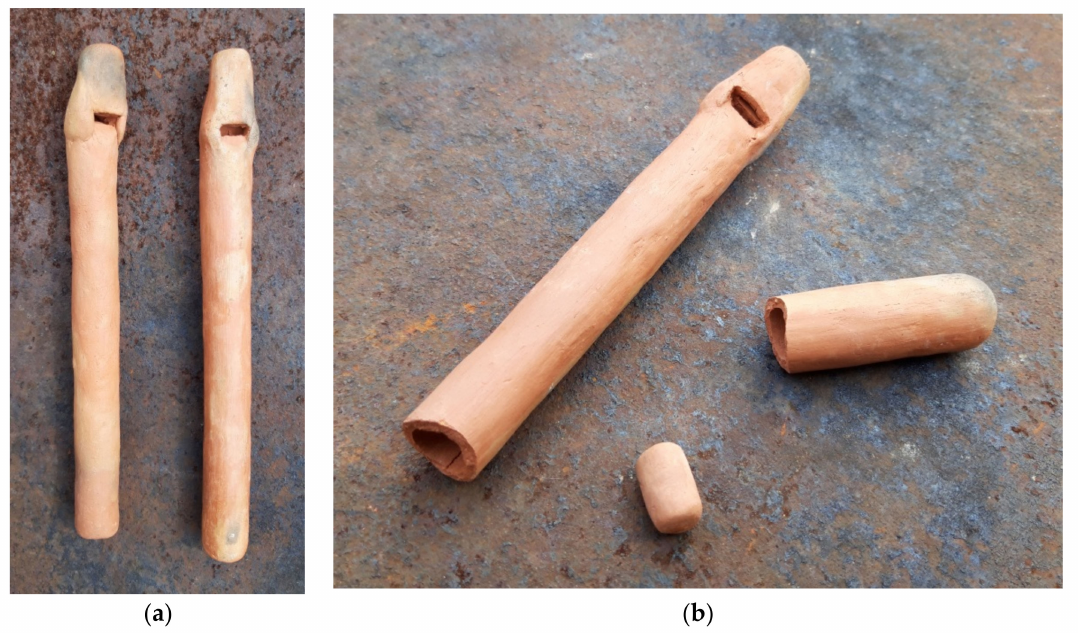
Figure 33. Piston whistles. Experimental models by Osvaldo Padr ó n (2020): ( a ) versions of slightly different dimensions, ( b ) broken model showing the piston.